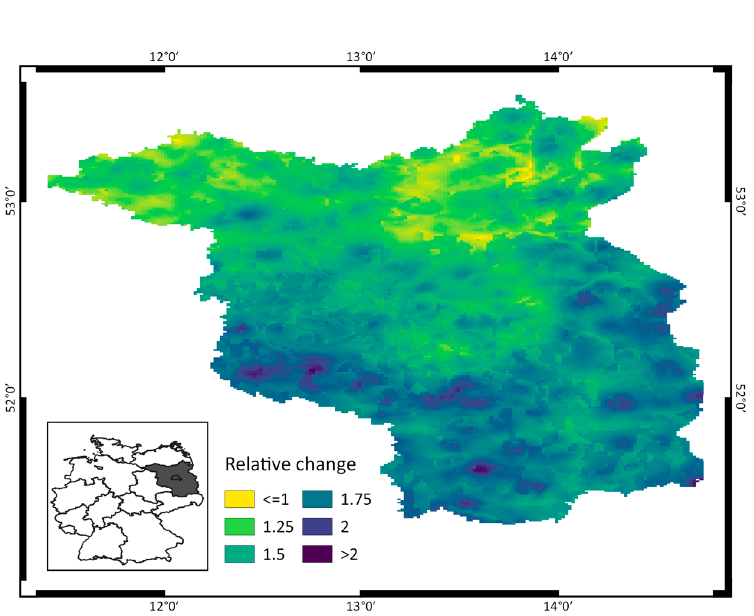
Figure 3. Ratio of R factors estimated with Equation (2) and the DIN regression model, based on REGNIE data (2001–2015); similar spatial pattern if Equation (2) was replaced by Equation (3) and the DIN model by Equation (1).